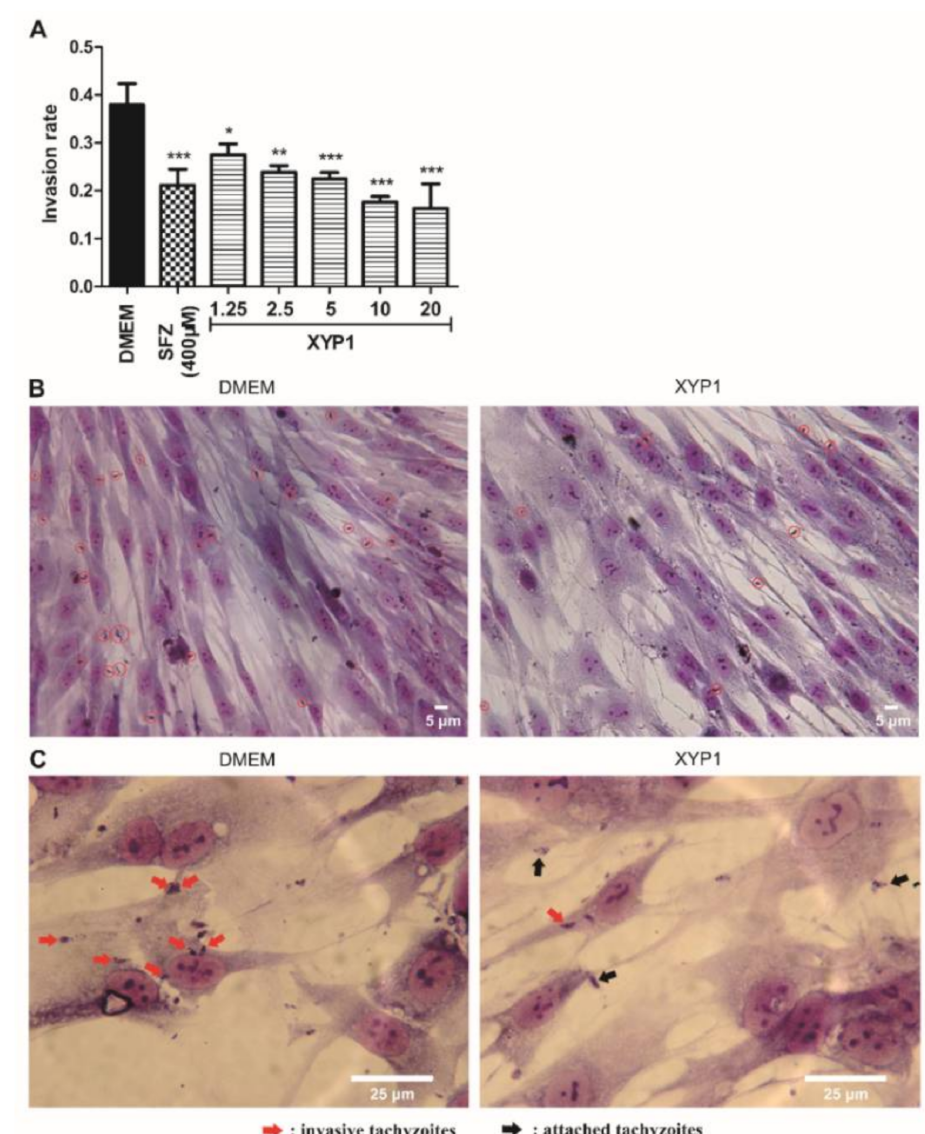
Figure 3. Effects of XYP1 on the invasion of T. gondii tachyzoites. Tachyzoites were pre-treated with DMEM (the negative control), SFZ (the positive control), and two-fold serial dilutions of XYP1 before exposure to host cells, respectively. Statistical results were expressed as the invasion rate ( A ). HFFs in DMEM group and XYP1 group (10 µ M) were observed by a light microscope (40 × ) ( B ). HFFs in DMEM group and XYP1 group (10 µ M) were also observed by a light microscope (100 × ) ( C ). The means were determined by values obtained from three independent experiments ( χ 2 -tests). * p < 0.05, ** p < 0.01 and *** p < 0.001 in comparison with control. Scale bars = 5 µ m ( B ); 25 µ m ( C